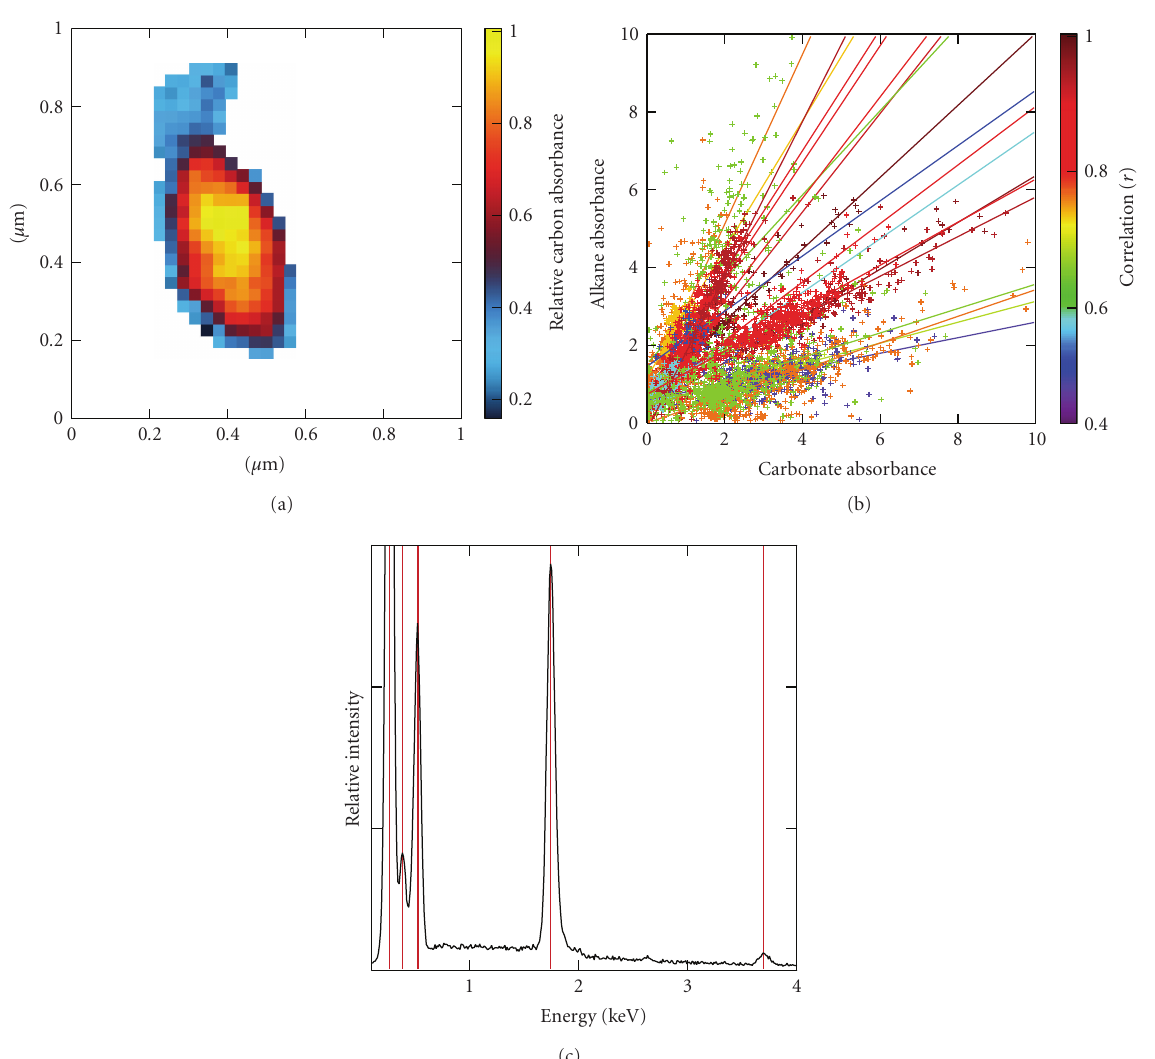
Figure 5: (a) Relative carbon absorbance per pixel from integrated NEXAFS particle-average spectrum for a calcareous phytoplankton fragments. (b) Alkane absorbance compared with carbonate absorbance for pixel-by-pixel fit of NEXAFS spectra of all calcareous phytoplankton type particles. Markers are colored by the correlation coe ffi cient for each least-squares linear regression (one color per particle). (c) EDX spectrum of the same particle at 10keV accelerating voltage. Vertical red lines mark the C, N, O, Si, and Ca absorbances from left to right. N and Si absorbances are from the sample